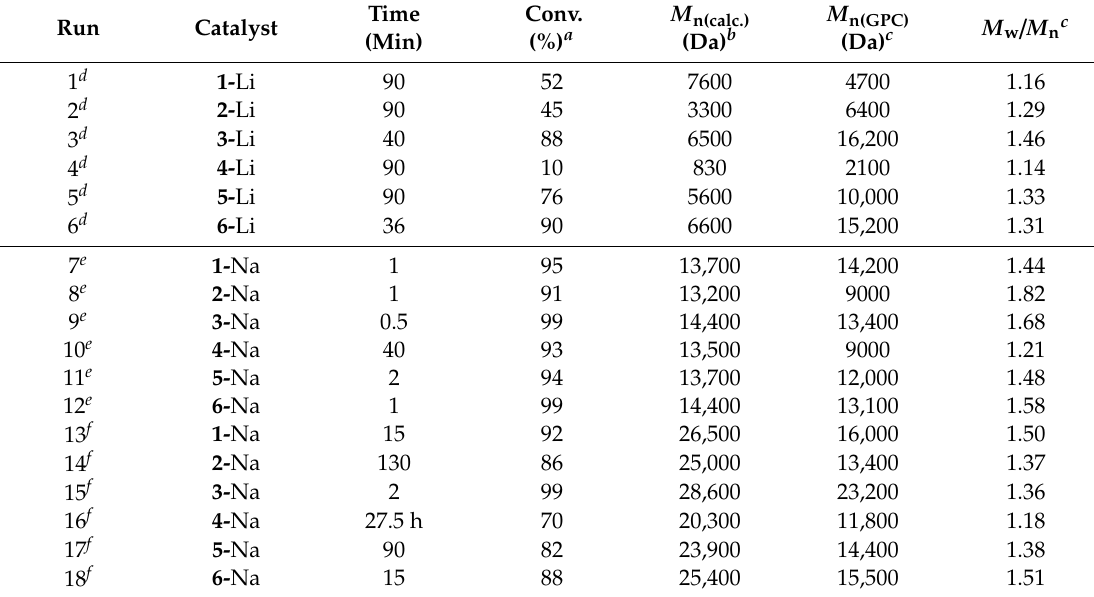
/ [BnOH] × conversion 0 0